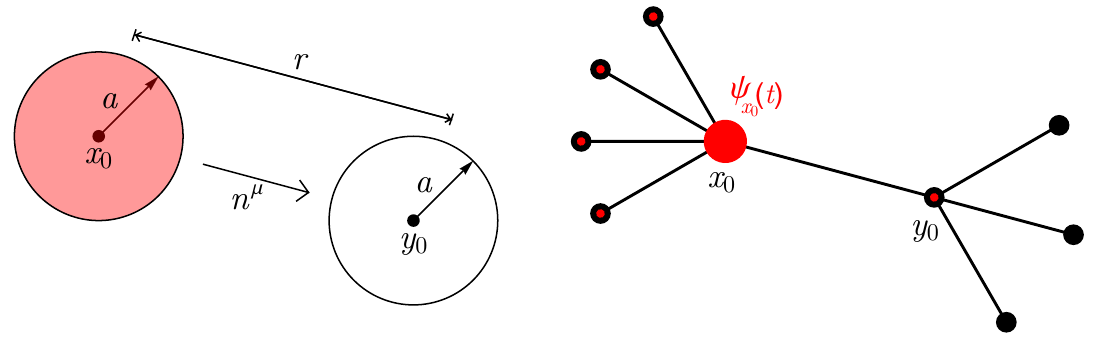
Figure 2 . Left: small spherical neighborhoods of nearby points in a smooth manifold provide a starting point for de(cid:12)ning Ricci curvature without (cid:12)rst de(cid:12)ning the Riemann tensor. Right: a similar construction on graphs hinges on replacing the small spherical neighborhood around a point x 0 with a probability distribution x ( t ) which for small t is concentrated at x 0 with a little bit of 0 weight on neighboring